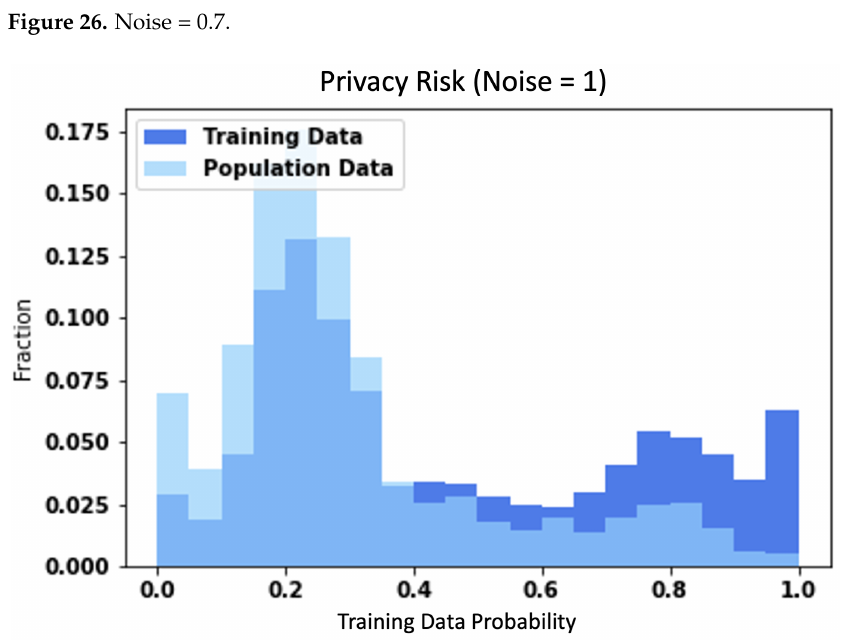
Figure 27. Noise =